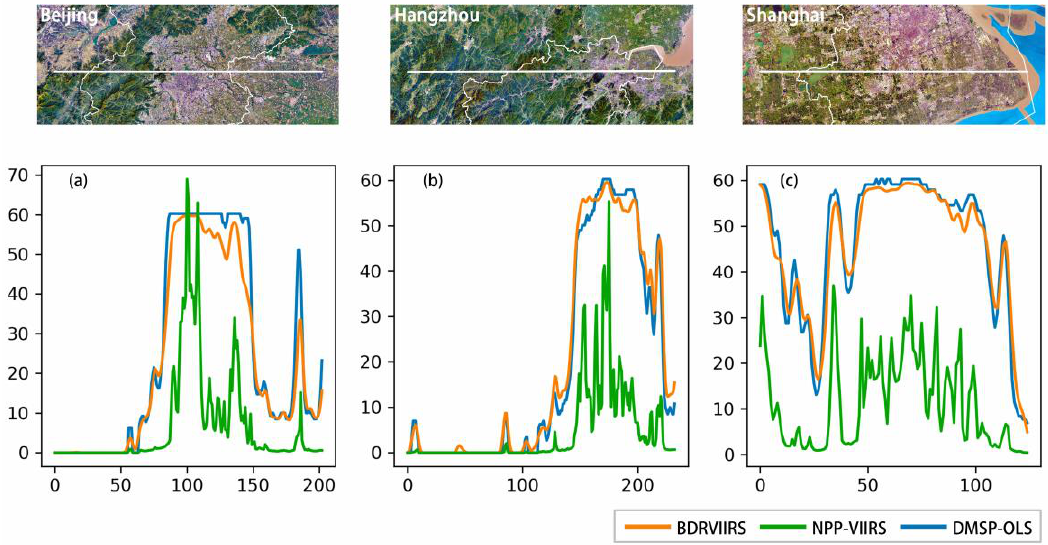
Figure 9. Google Earth images and transects in Beijing ( a ), Hangzhou ( b ), Shanghai ( c ). Yellow curves represent the transects of BDRVIIRS data, green ones represent the transects of NPP-VIIRS data, and blue ones are representing the transects of DMSP-OLS data.